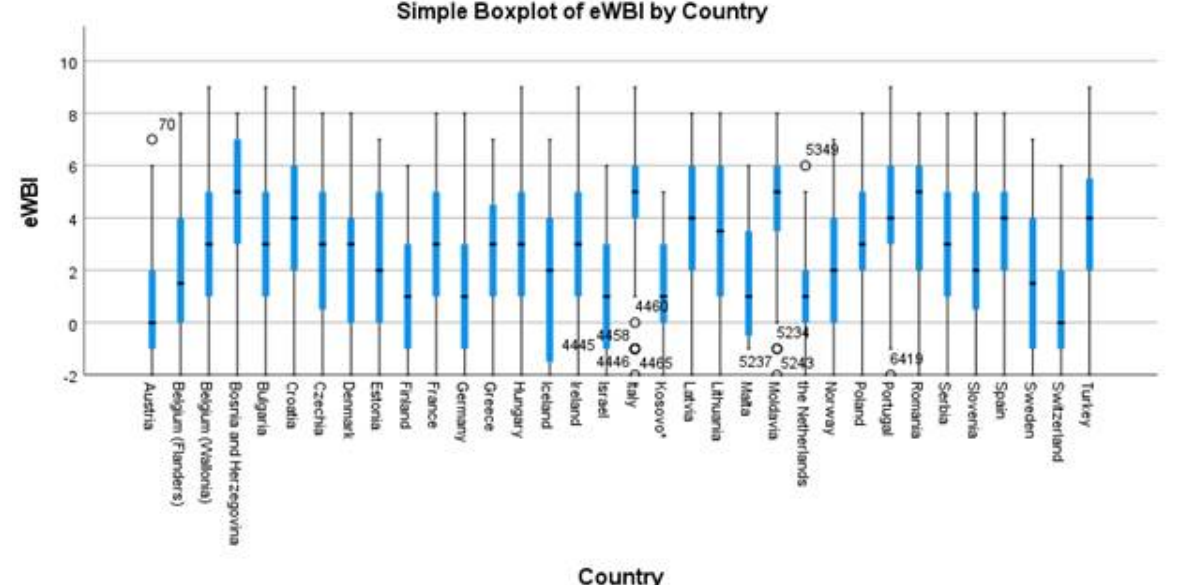
Figure 1. Box plot of GPs’ total eWBI scores (on a scale from − 2 to 9) during the COVID-19 pandemic in 2021 by country ( n = 3711). * All references to Kosovo, whether the territory, institutions, or population, in this project shall be understood in full compliance with the United Nations Security Council Resolution 1244 and the ICJ Opinion on the Kosovo declaration of independence, without prejudice to the status of Kosovo.